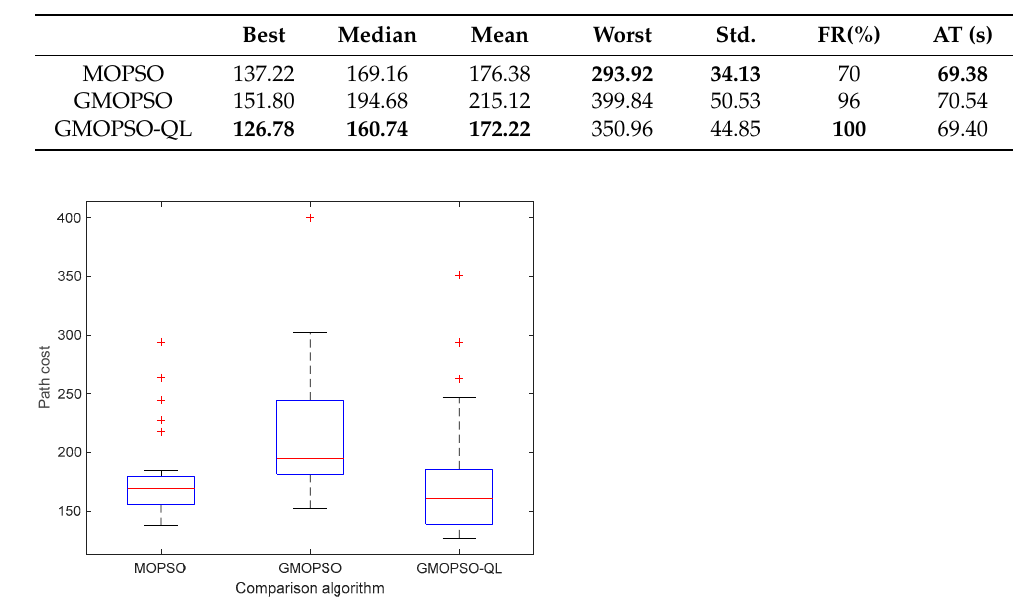
Table 1. Comparison results of various algorithms in Case 1.